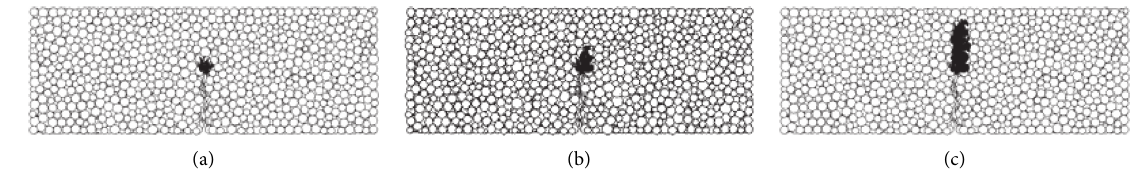
Figure 13: Microcracks distribution in SC3PB specimen (B1). (a) Crack initiation. (b) Crack growth. (c) Specimen failure.